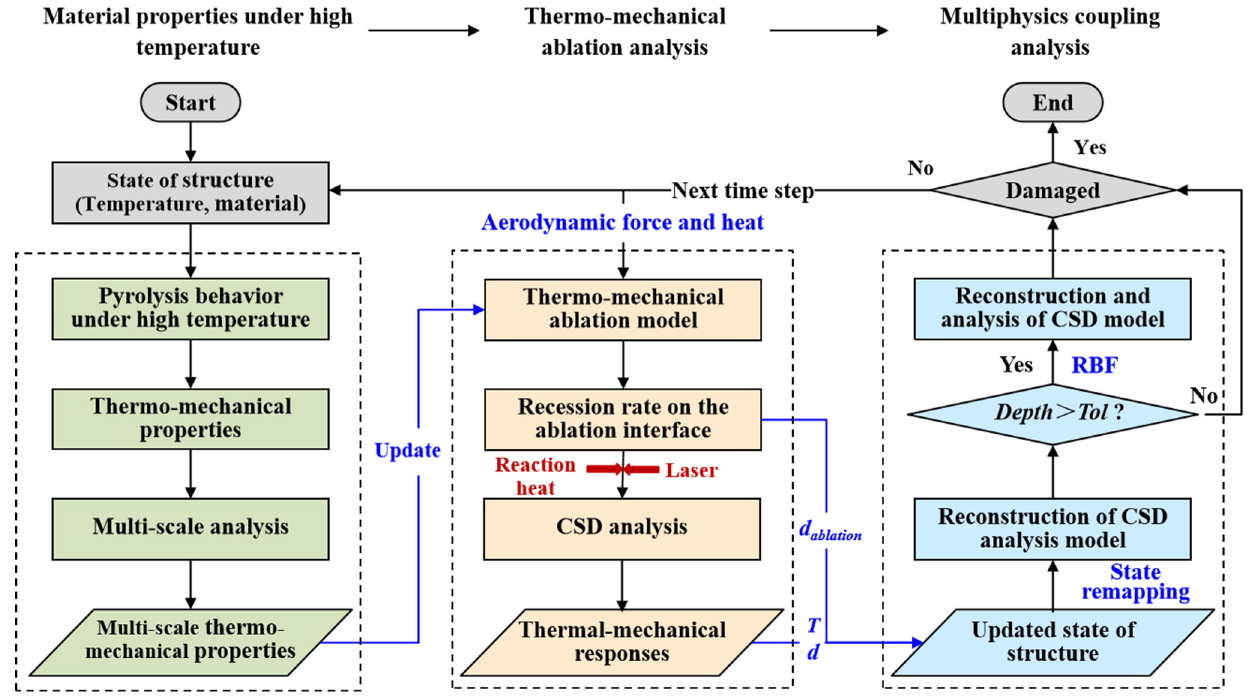
Figure 3. The flowchart of coupled thermal-fluid-ablation analysis.